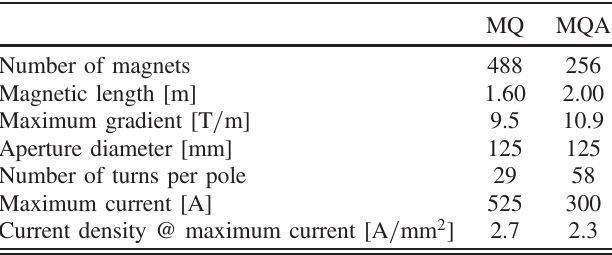
TABLE III. Main parameters of the LEP resistive quadrupoles.